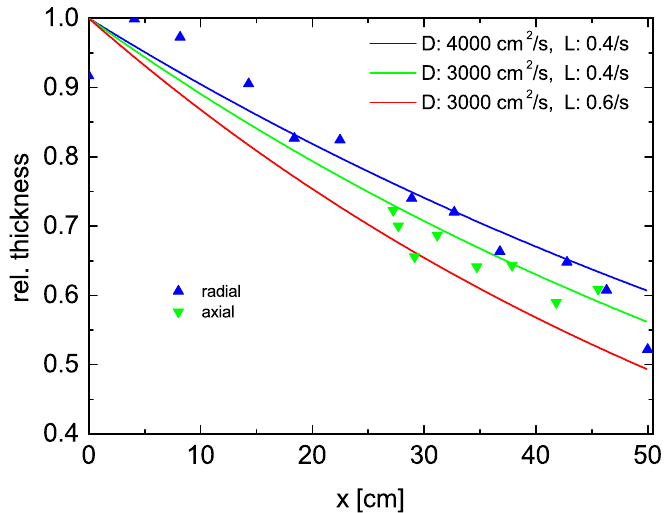
Figure 8. Fitting of the experimental reactor deposition data from Figure 7 with the diffusion loss Equation (4) at 20 mTorr and a 300 K surface temperature. Distance values, x , are relative to the cracking unit